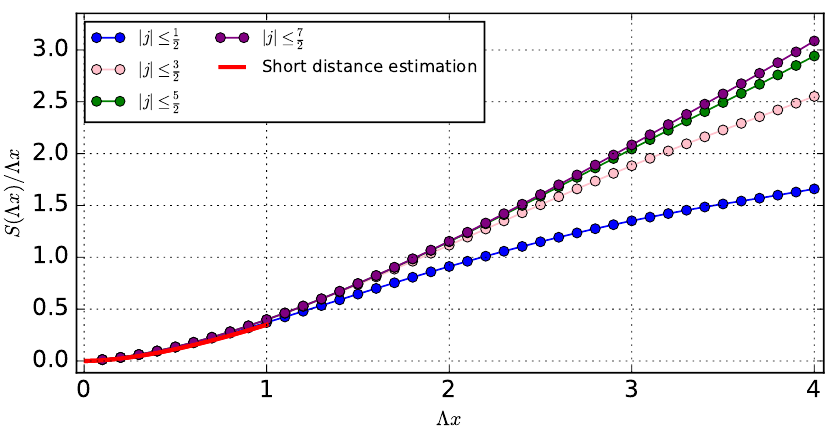
Figure 17 . Entanglement entropy pro(cid:12)le obtained for (cid:3) a = 0 : 01 ( x < 4 = (cid:3)). Convergence upon increase of the maximum value of j j j is observed. We lack numerical data to comment on how reliably the long distance behaviour reproduces an area law.